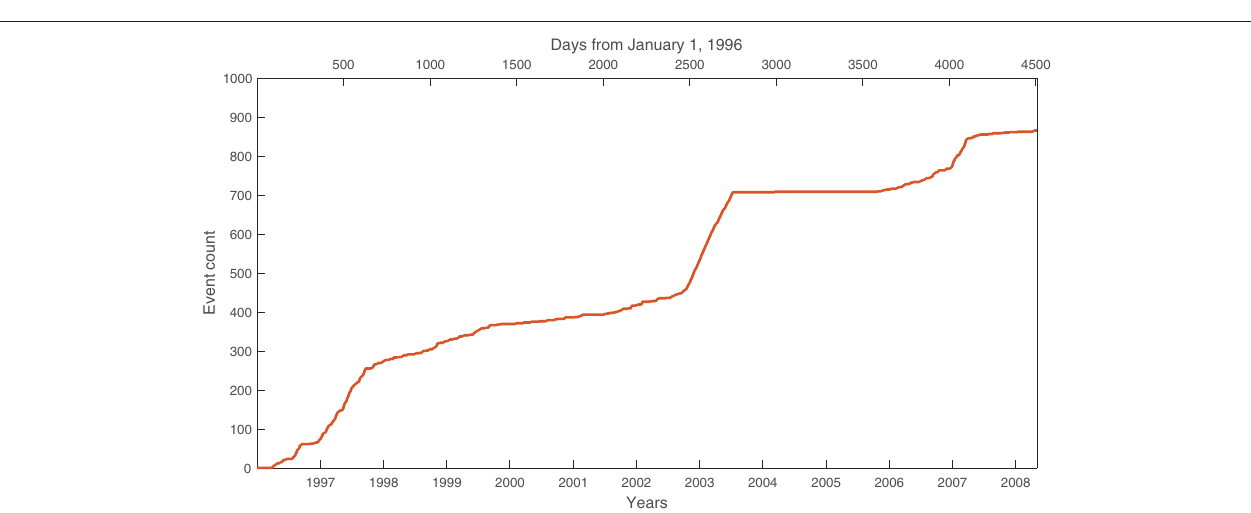
FIGURE 3 | Cumulative count of PDC events, illustrating that PDC frequency varies over time. Note slope of curve is sometimes steep (in high-activity periods) and sometimes shallow (in low-activity periods or dome growth